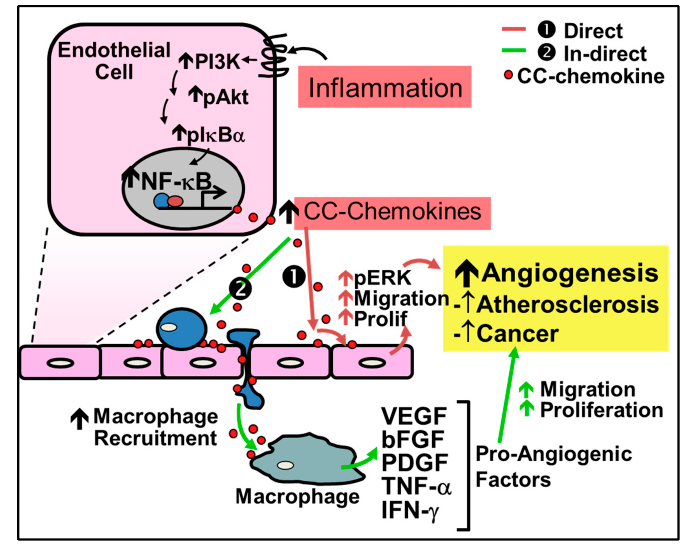
Figure 2. Regulation of inflammation-driven pathological angiogenesis by CC-chemokines. CC-chemokines regulate angiogenesis through two pathways: (1) the direct pathway; and (2) the indirect pathway. (1) Red Arrows - Direct stimulation by CC-chemokines promotes signaling pathways such as PI3K, MAPK, and ERK1/2 to increase nitric oxide production and promote endothelial cell proliferation and migration leading to neovessel formation; (2) Green Arrows - Indirect stimulation involves the initial recruitment of macrophages to the site of inflammation by CC-chemokines, which secrete pro-angiogenic factors such as VEGF, bFGF, PDGF, TNF- α and IFN- γ that promote angiogenesis.